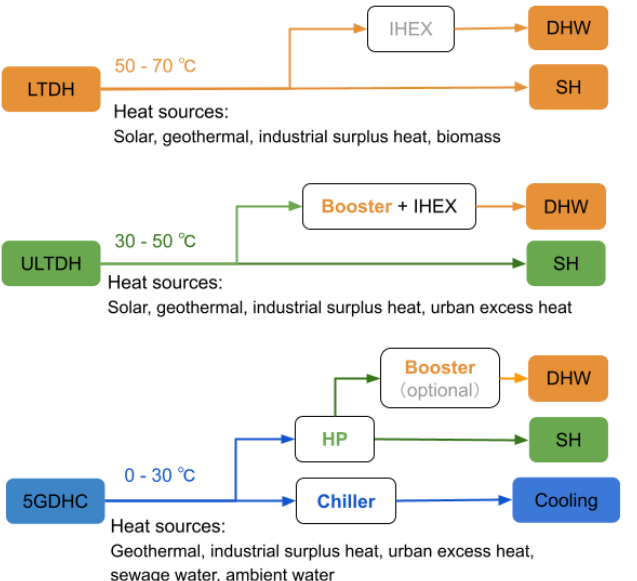
Figure 11. The temperature levels for three different DH configurations: LTDH, ULTDH and